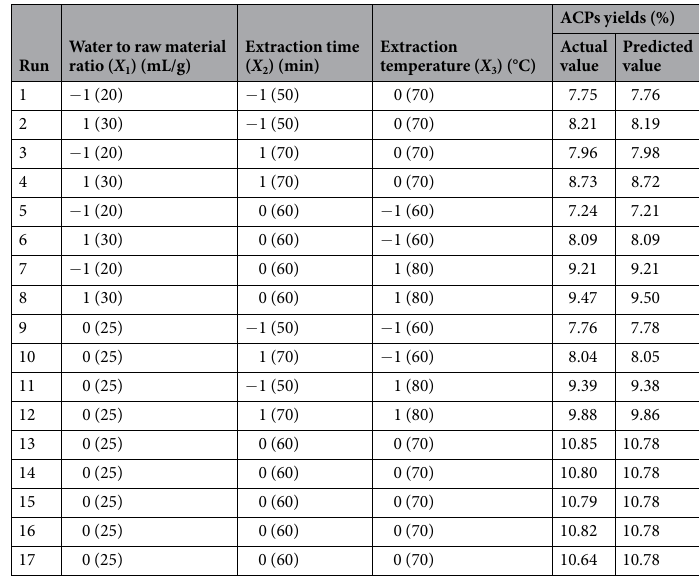
Table 1. The Box-Behnken design matrix and the results of the ACPs yields.